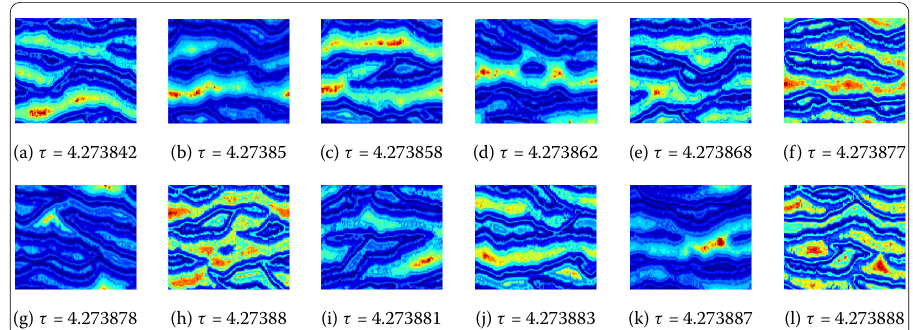
Figure 10 Pattern transition with the variation of τ covering [4.27384,4.27389]. In this range, all the patterns exhibit similar configuration but the pattern structures fluctuate. The conditions for pattern simulations are exactly the same as those in Fig. 3